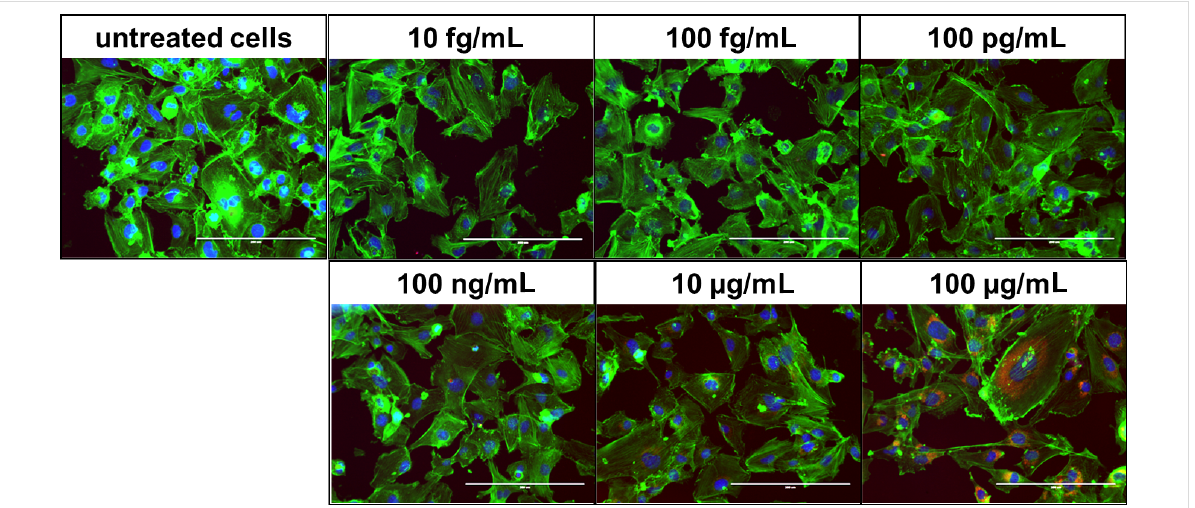
Figure 2: CeO 2 nanoparticles were localized peri-nuclearly within endothelial cells. HMEC-1 were exposed to different concentrations of CeO 2 nano- particles (sample #B, 35 nm) for 48 h. blue: nucleus (Hoechst); green: actin (Alexa Fluor ® 546 Phalloidin); red: CeO 2 nanoparticles ( N -(2,5- bis(dimethylethyl)phenyl)- N ’-(3-(triethoxysilyl)propyl)perylene-3,4,9,10-tetracarboxylic acid diimide label); magnification: 20×.